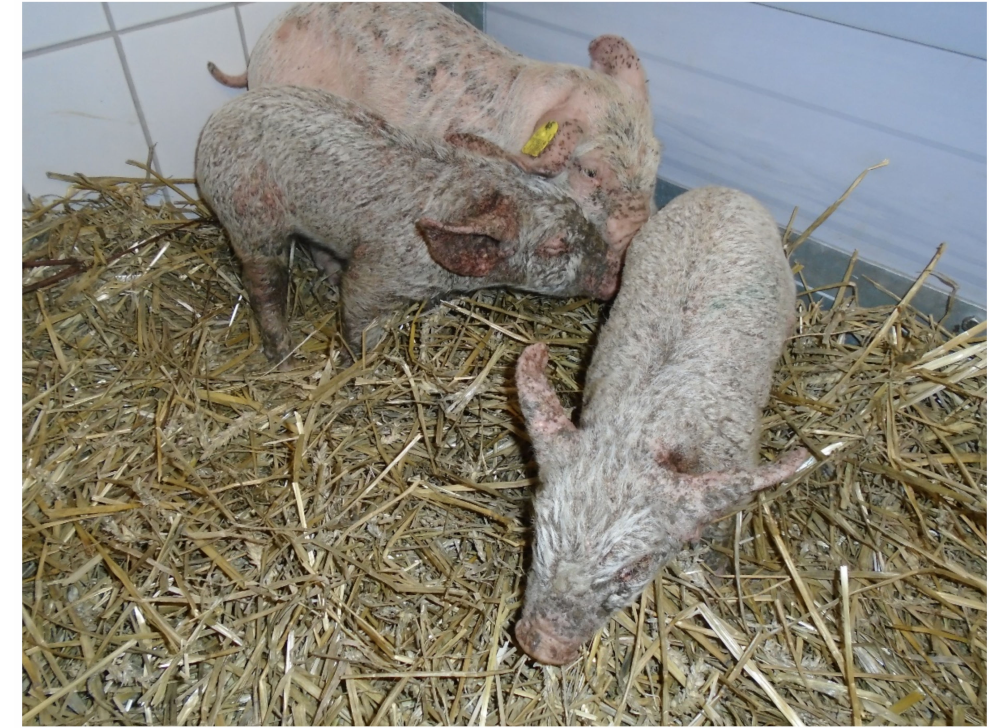
Figure 1. Piglets sent for further diagnostics showing typical signs of greasy pig